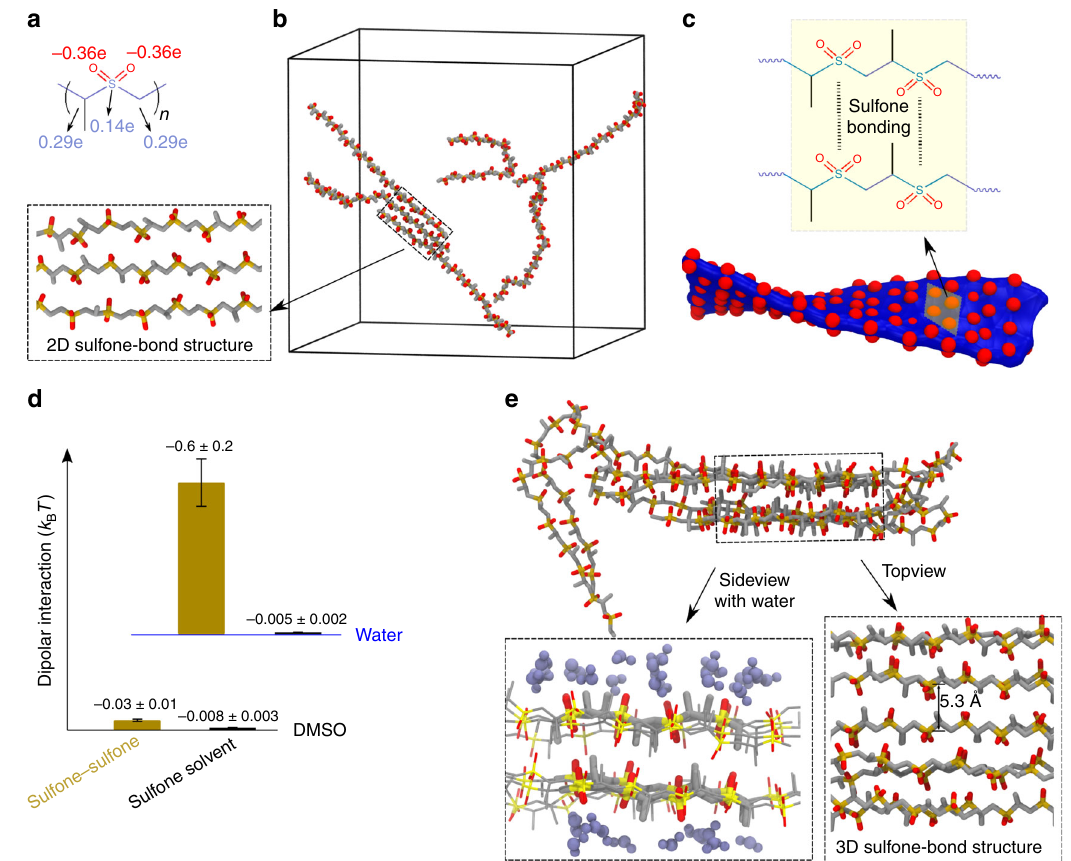
Fig. 1 Structural features of PPSU. a Chemical structure of PPSU showing the polymer backbone and oxygen atoms that carry positive/negative (blue/ red) atomic partial charges, respectively. b Atomistic simulation snapshot showing a dissolution-complementarity equilibrium in DMSO for six PPSU 20 chains. Inset is a superstructure formed by PPSU self- complementarity. c PPSU self-complementarity leading to a 2D reversible superstructure with enrichment of oxygen atoms on the surface. Formation of 3D superstructures is inhibited in DMSO due to the strong repulsion among layers. d Average dipolar energies per dipole-dipole pair of sulfone – sulfone and sulfone-solvent. Error bars represent the standard deviation from three parallel simulations. e Atomistic simulation snapshot showing the formation of a 3D superstructure through PPSU bundling in water. Inset showing the 3D superstructure with or without water